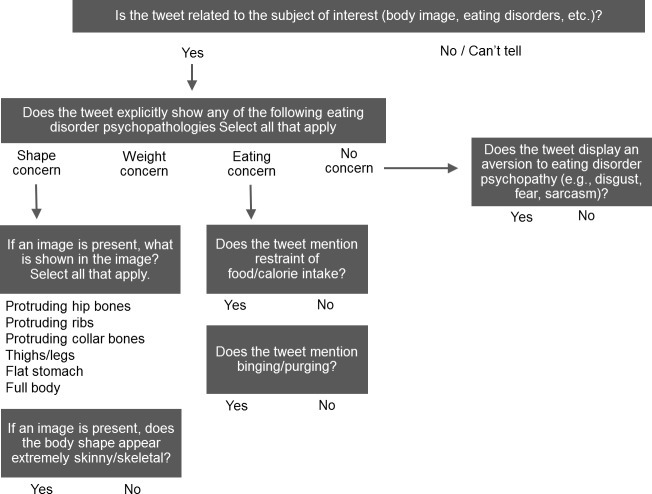
Flow of items to assess presence of eating disorder-related themes in tweets.